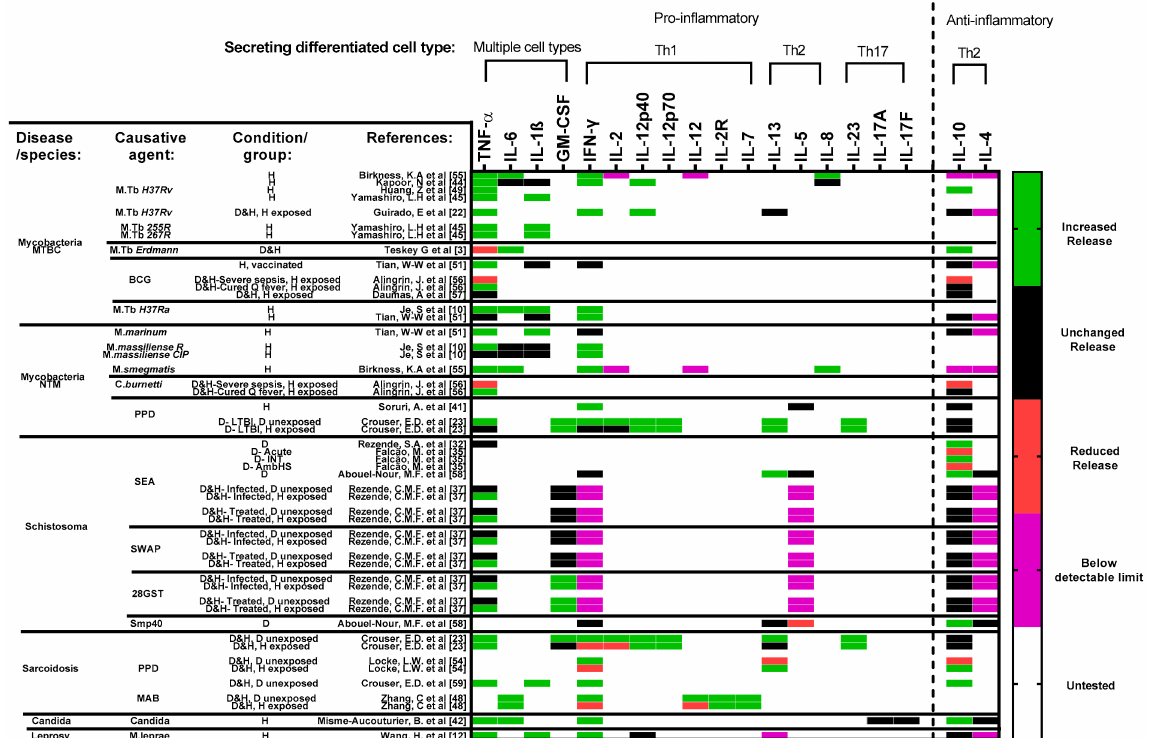
Figure 6. Cytokine secretion profile across included studies. Studies are sorted horizontally according to disease and choice of antigens. Studies focused on mycobacterial diseases are further sorted top-down, based on the virulence of respective strains/species (Table S2). Increased or decreased secretion/release is determined by at most a significant ( p < 0.05) change observed per cytokine in each study’s results. Untested (white) refers to markers that were not included per study. Several cytokines were tested for but remained below a detectable limit throughout the course of experiments. In this case, since the highlighted cytokines were tested for and not omitted from the respective studies, they have also been included in the figure. Data in such cases are highlighted in purple.